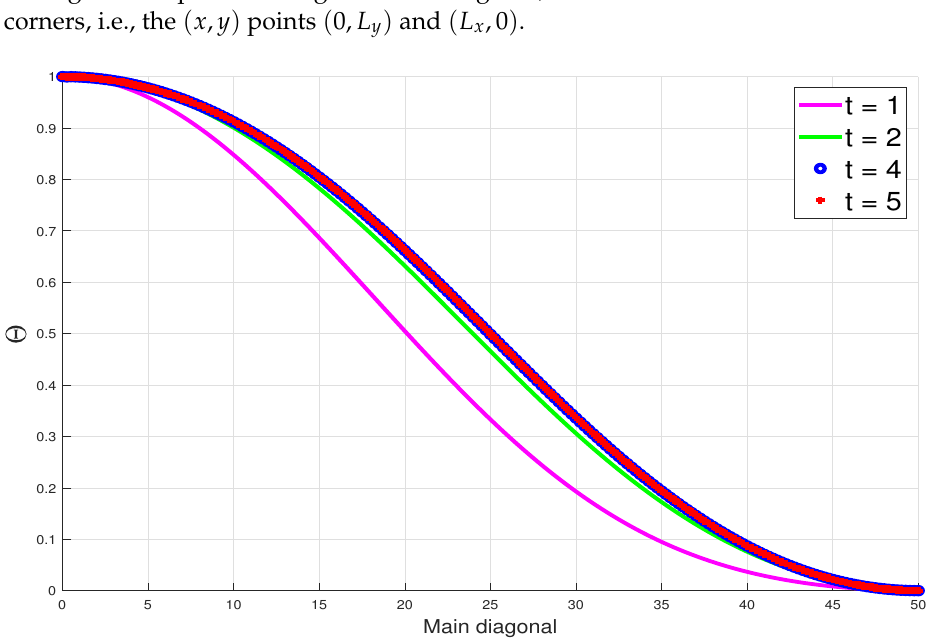
Figure 4. Time development of steady-state temperature profiles.